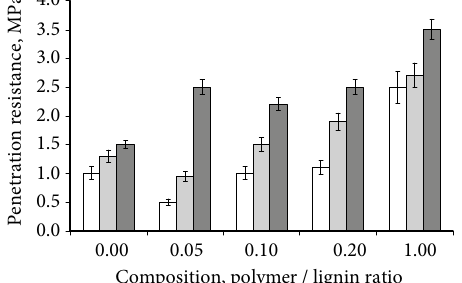
Fig. 1. Penetration resistance of reinforced soil layers versus the LSC composition; concentration of the applied solutions: , 50 g/ l ;